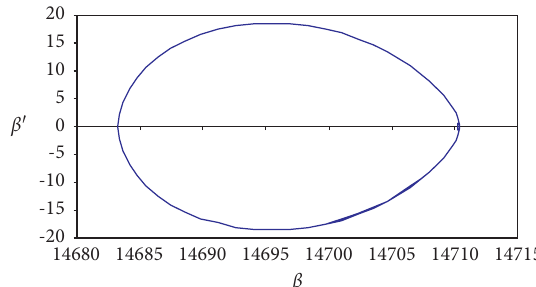
Figure 33: The stability phrase β ′ and β for case (iv) in Section